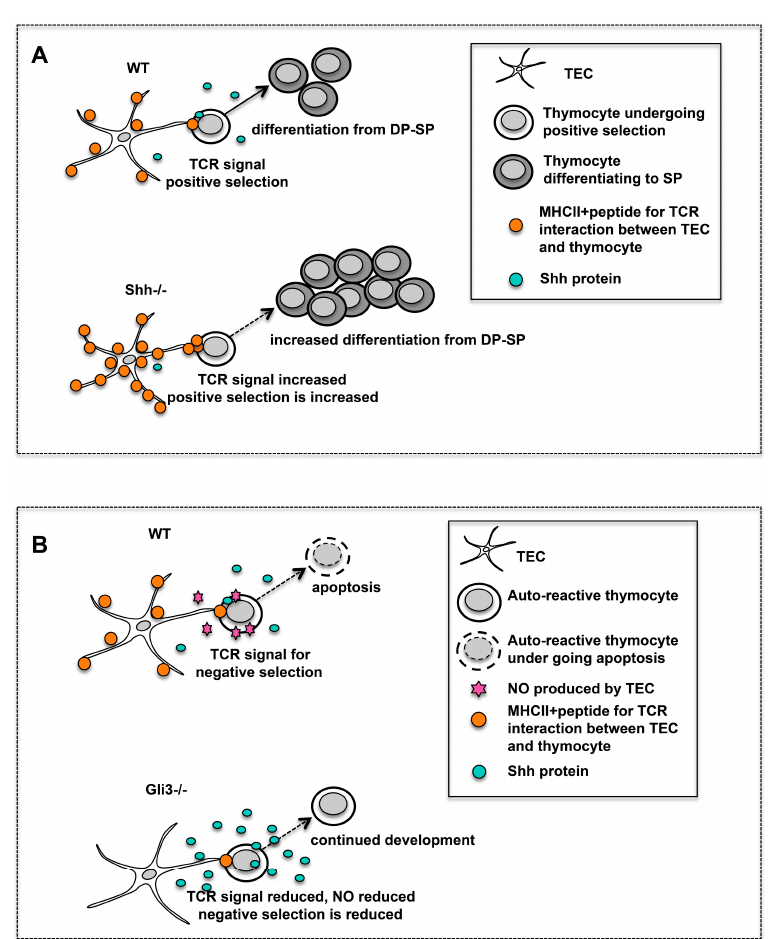
Figure 4. Hh signalling at the transition from DP to SP thymocyte. ( A ) The cartoon illustrates the influence of Shh on positive selection. Positive selection is increased in the Shh − / − thymus and the proportion of CD4SP cells is increased. Cell surface expression of major histocompatibility complex class II (MHCII) is increased on Shh − / − TEC compared to wild type (WT) TEC. ( B ) The influence of Gli3 on negative selection. In the Gli3 − / − thymus MHCII expression is decreased in TEC and nitric oxide (NO) activity is decreased. This may allow SP thymocytes to escape from negative selection.